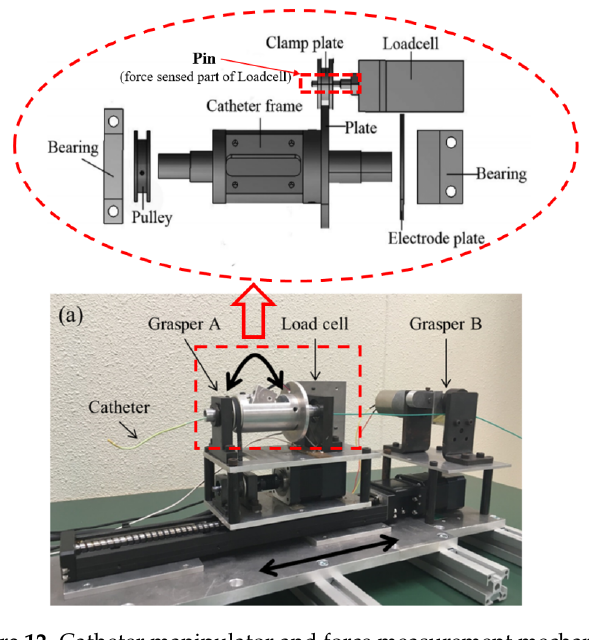
Figure 12. Catheter manipulator and force measurement mechanism.